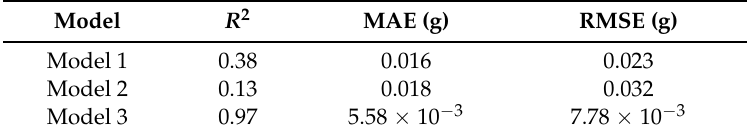
Table 4. Adaptive neuro ‐ fuzzy inference system (ANFIS) models performance evaluation.